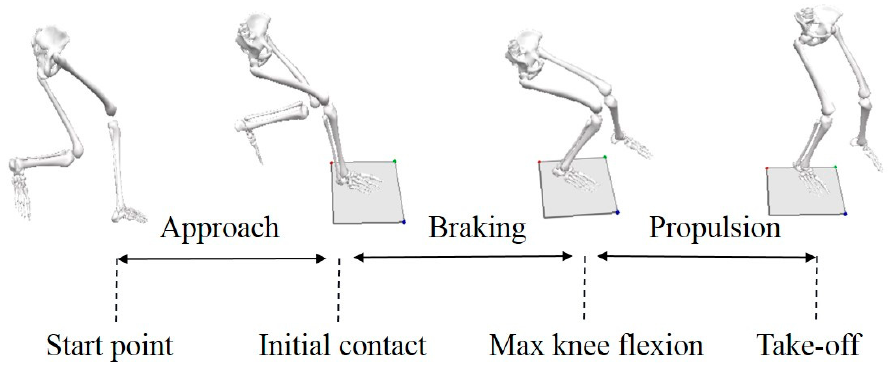
Figure 1. The process of a jump following a